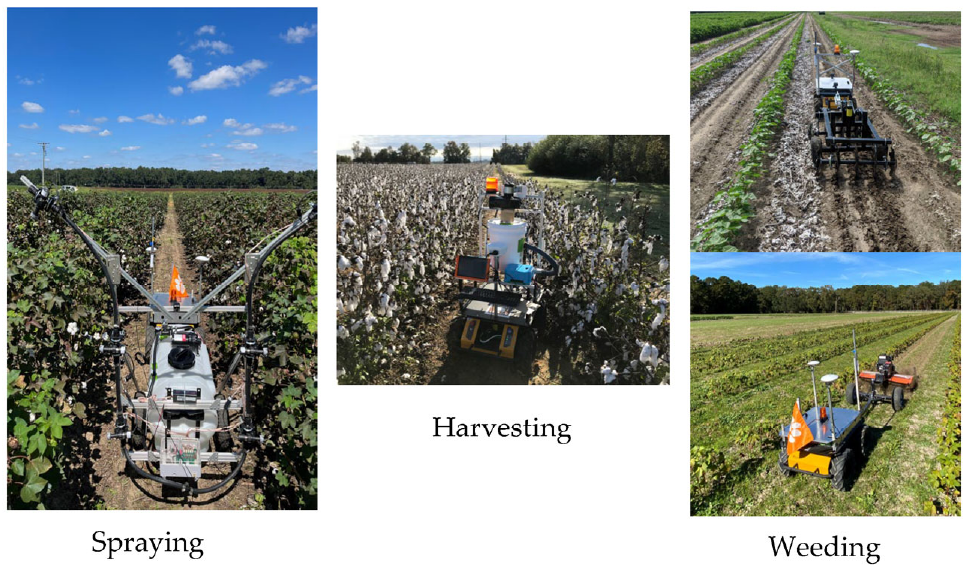
Figure 2. Mobile robots’ different applications in Agriculture.